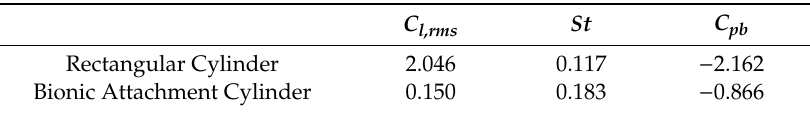
Table 4. Comparison of the aerodynamic coe ffi